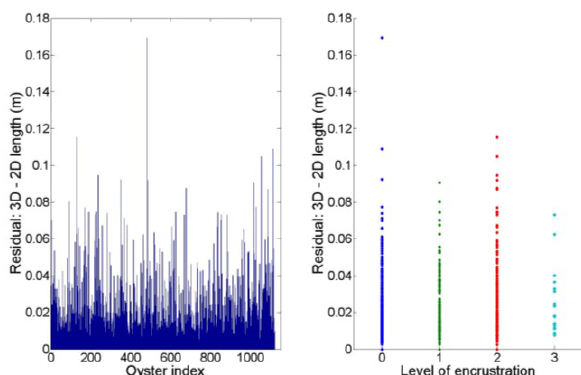
Figure 7: Left: histogram of absolute residuals between 2D and 3D lengths; Right: number of overlaps for each shell among 1121 Crassostrea oysters